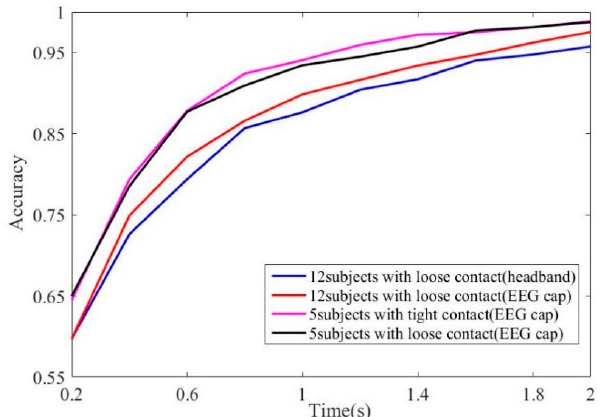
Figure 5. The results of the classification accuracy rate of the headband and the proposed EEG cap with different data lengths. The pink line represents the mean accuracy of five subjects under tight contact with the EEG cap; the black line represents the mean accuracy of five subjects under loose contact with the EEG cap; the red line represents the mean accuracy of twelve subjects under loose contact with the EEG cap; and the blue line represents the mean accuracy of twelve subjects under loose contact with the headband.